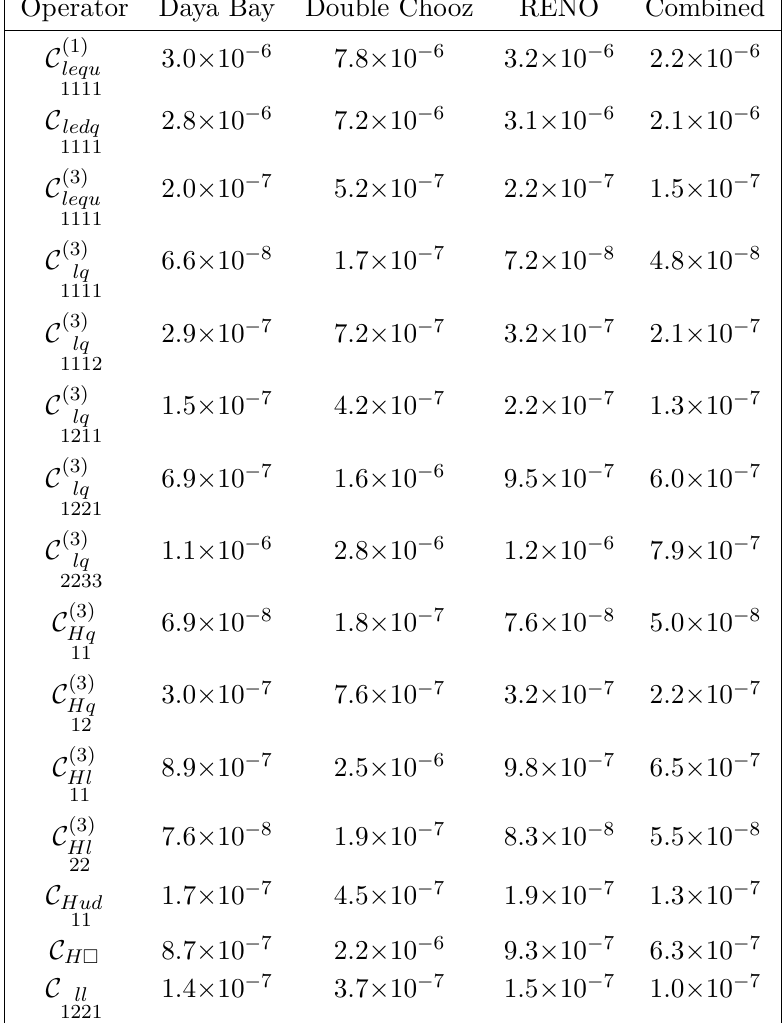
Table 8 . Upper bounds on the Wilson coefficient C as obtained from the reactor neutrino exper- iment data. The constraints are provided in units of TeV at 95% CL significance for Daya Bay, Double Chooz and RENO, both individually and